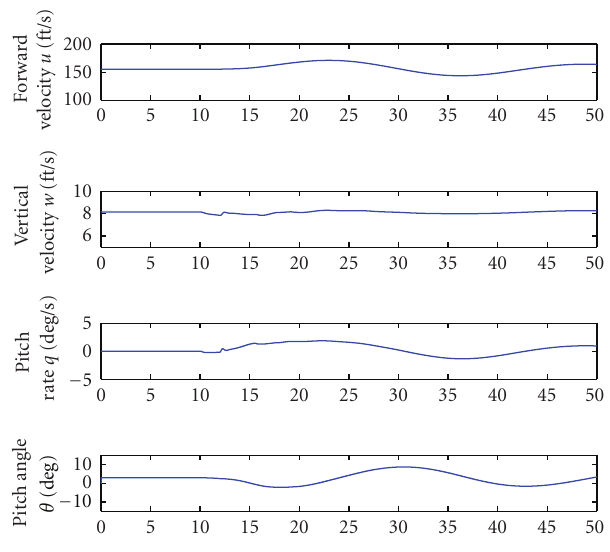
Figure 10: Time history of longitudinal states.